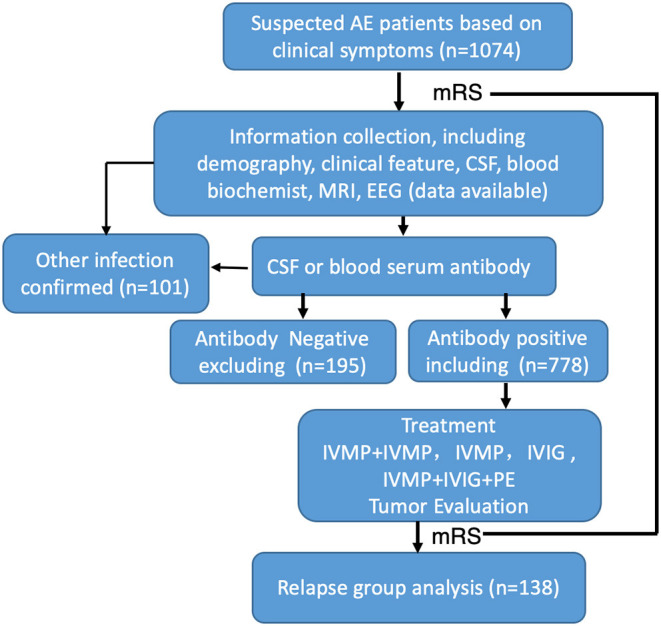
Flow chart of patients' inclusion and exclusion. One thousand and seventy-four patients were initially screened, 296 of them were excluded, a total of 778 AE patients were enrolled in the study.